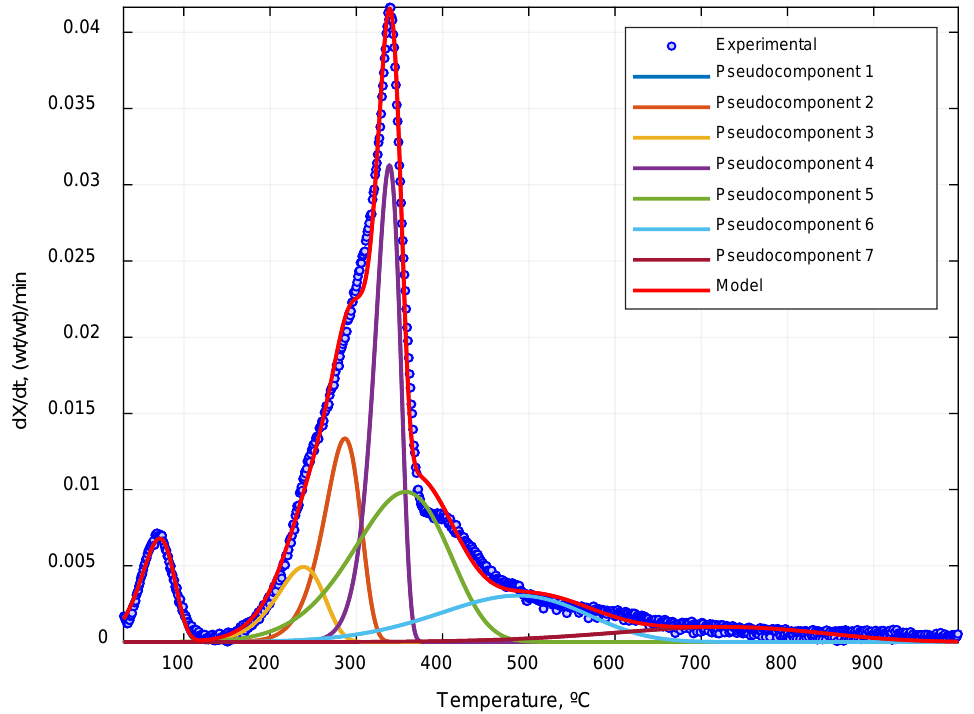
Figure 3. Model fitted to the experimental pine bark DTG curve.